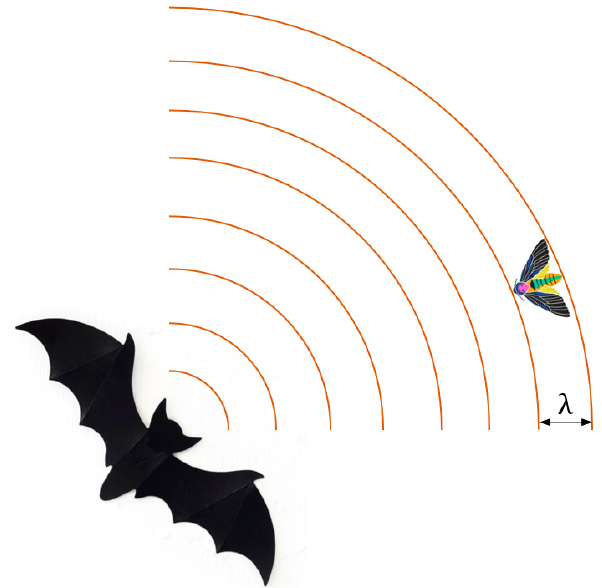
Figure 2. Echolocation hunting of the bat. Table 2. Algorithmic process of BA . The Pseudo Code of Bat Algorithm